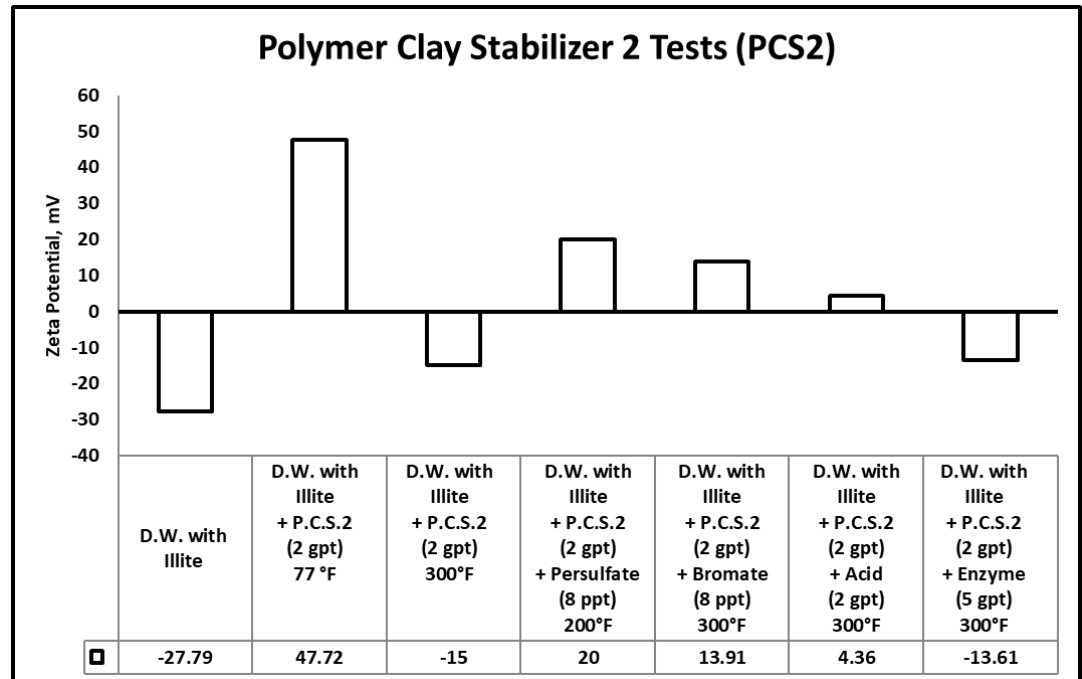
Figure 13. Zeta potential results for the tests involving gel breakers and polymeric clay stabilizer 2.